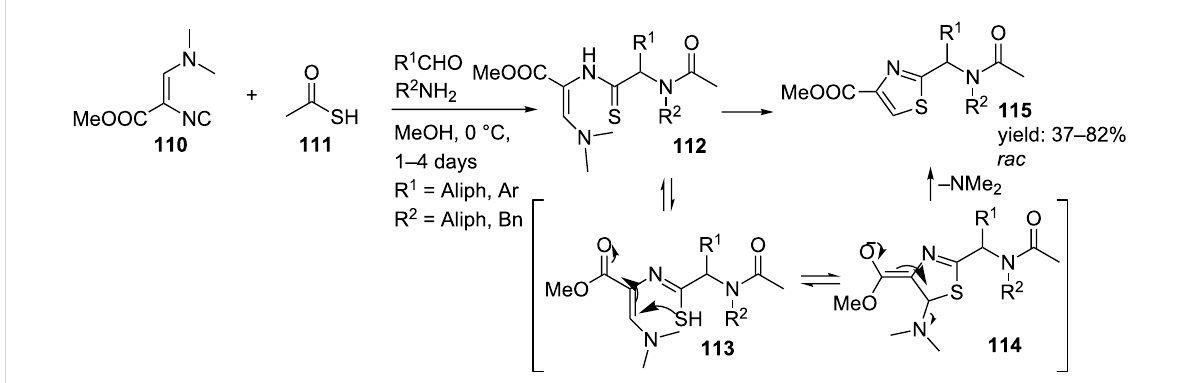
Scheme 35: The Ugi-4CR towards 2,4-disubstituted thiazoles.